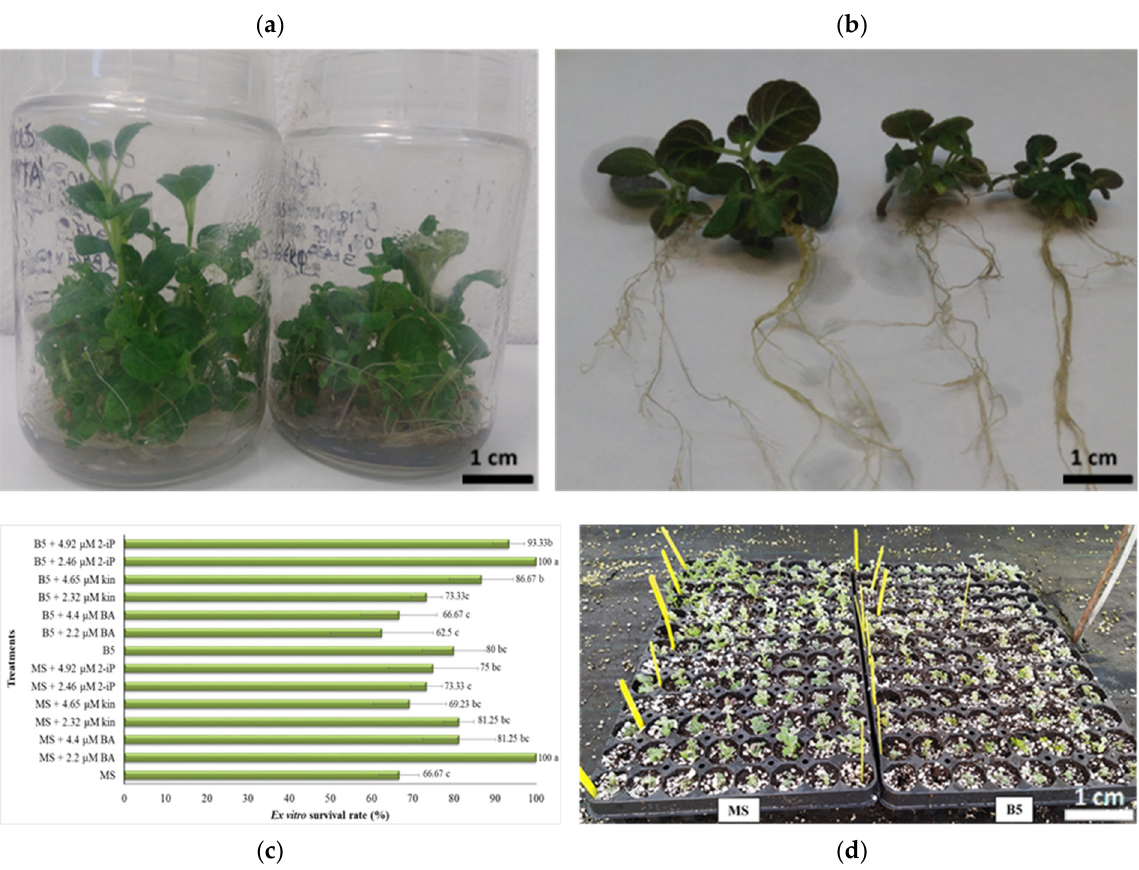
Figure 2. Micropropagation and ex vitro acclimatization of in vitro rooted plantlets of O. dictamnus explants: ( a , b ) Shoot proliferation and rooting after 30 days of in vitro culture in MS basal nutrient medium supplemented with 2.2 μ M BA, 0.25 μ M IBA, 0.3 μ M GA 3 , 20 g L − 1 sucrose and 6 g L − 1 Plant